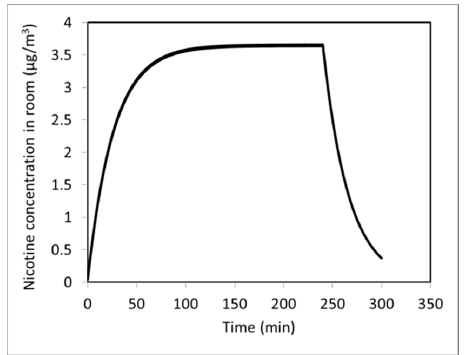
Figure 6. Computational results for nicotine concentration in the mEEC under the described study conditions.